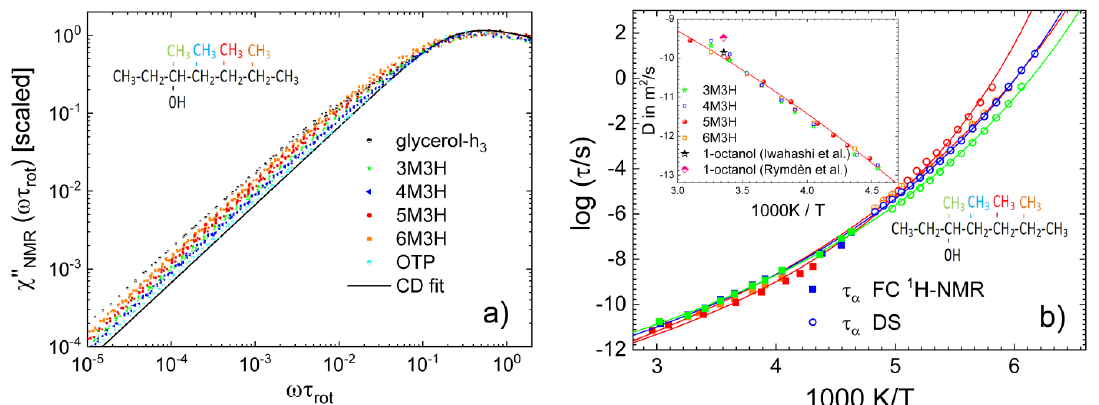
Figure 10. ( a ) The low-frequency part of the FC 1 H NMR susceptibility master curves of the four octanol isomers. For comparison, the susceptibilities of glycerol-h 3 and o-terphenyl and a CD sus- ceptibility are included. ( b ) Rotational time constants obtained from DS (open symbols) and FC 1 H relaxometry (solid symbols). Inset: diffusion coefficients determined by FC 1 H relaxometry and from the literature [124,125]. The solid lines are guides for the eye.